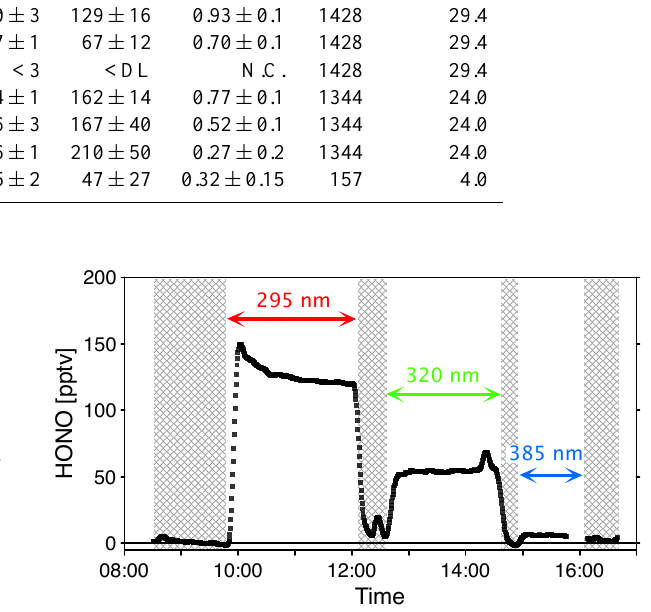
Figure 5. Photochemical release of HONO from a surface snow collected at DC when irradiating it at a temperature of − 16 ◦ C (see Table 1) and inserting filters with cut-off points at 295, 320, and 385nm on the xenon arc lamp (see Sect. 4). Vertical grey bands correspond to periods over which the lamp was switched